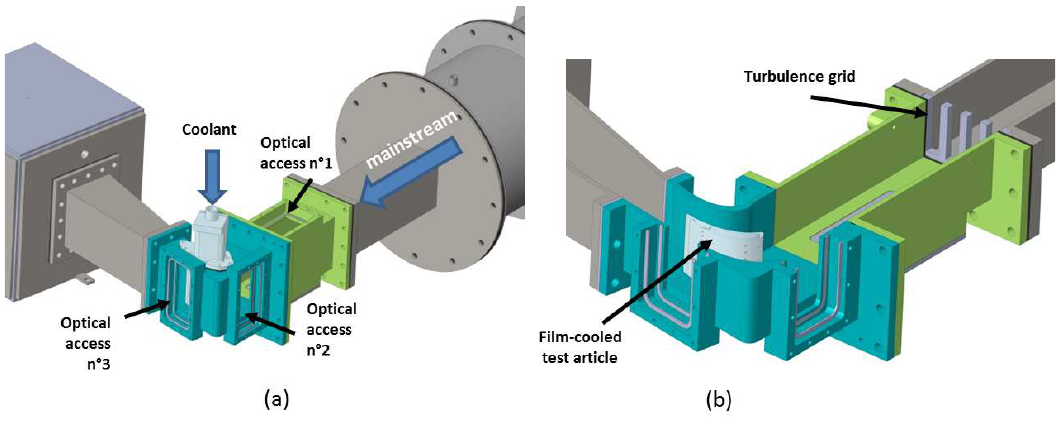
Figure 1. Sketch of the cascade test rig: overall view ( a ) and section of the test article area ( b